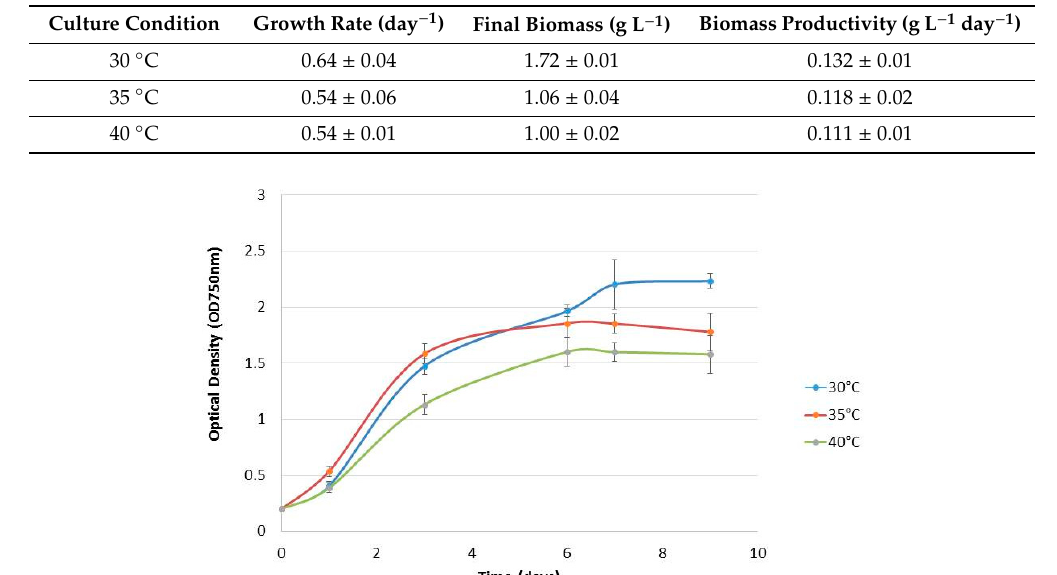
Table 1. E ff ect of temperature on growth parameters of the strain Chlorella sp. QUCCCM3. Number of replicates generating the mean, n = 2.